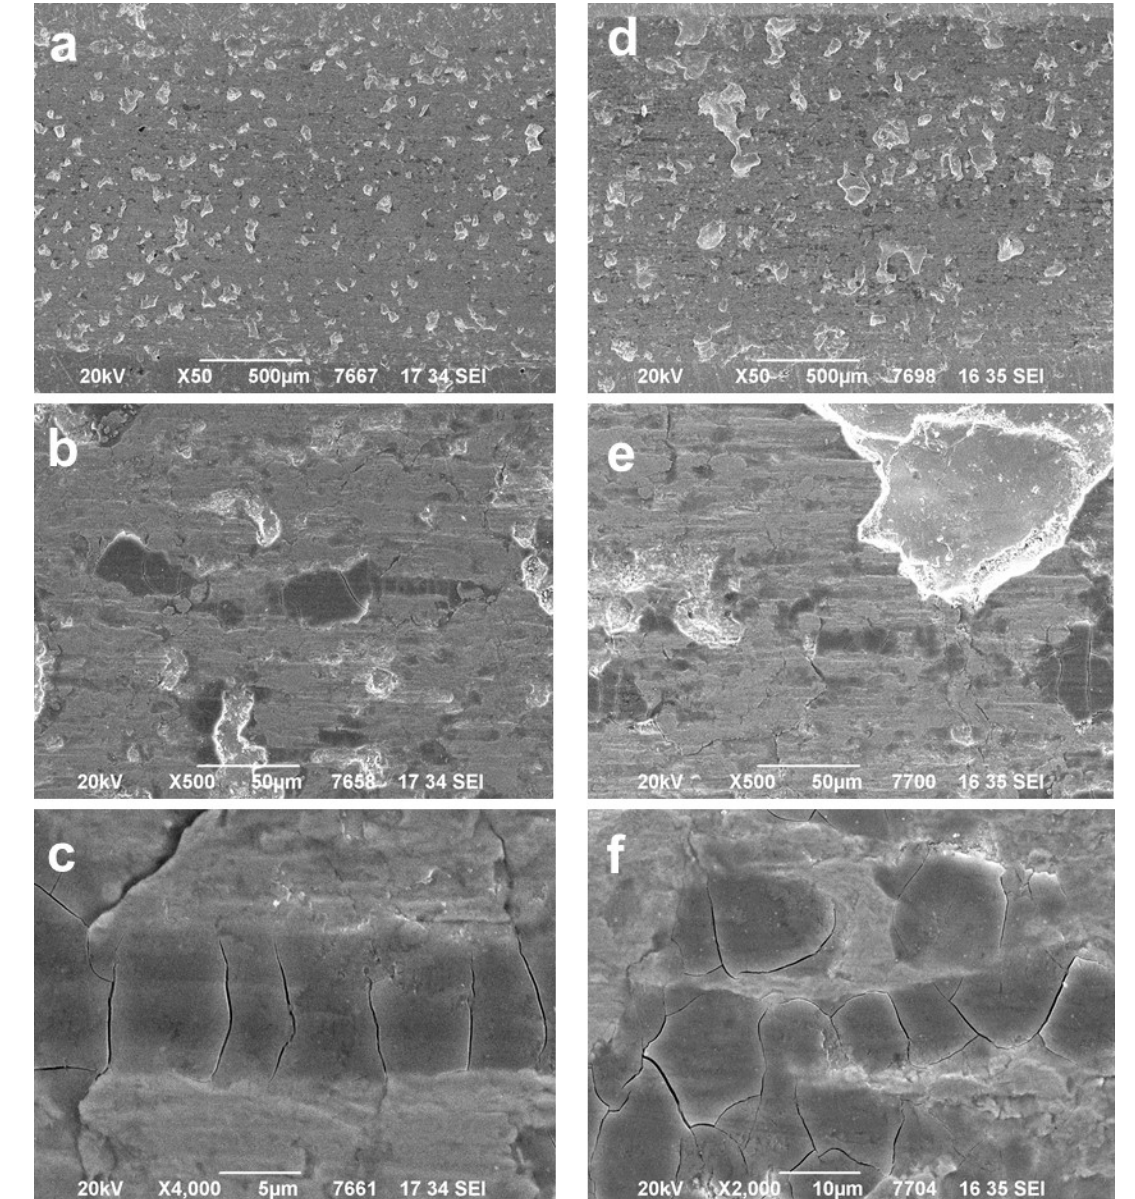
Figure 4. Wear mechanism for APS (a,b,c) and TWAS (d.e.f) sprayed